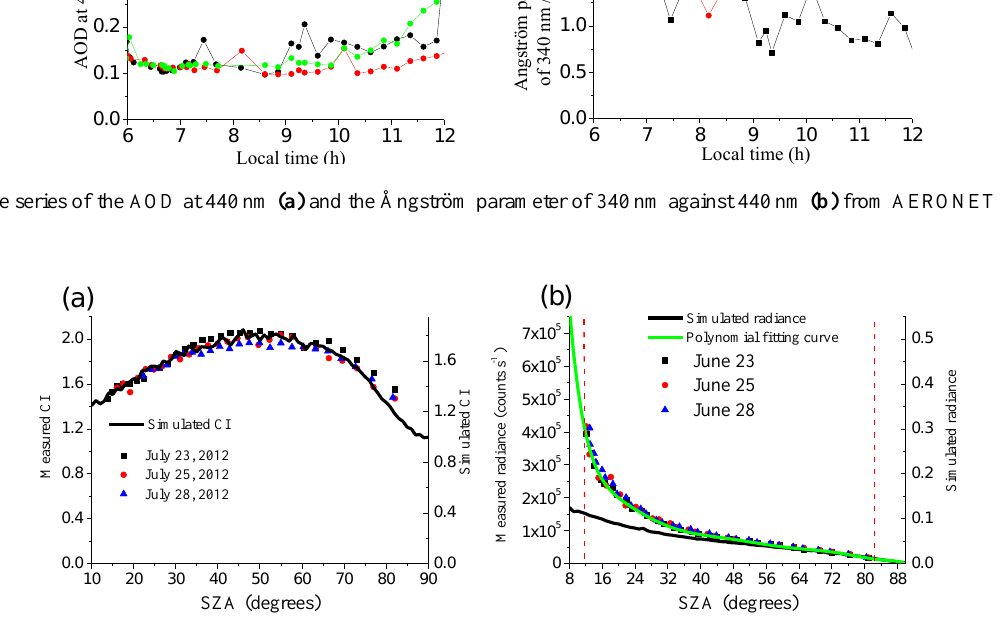
Figure 4. The comparisons of zenith measurements of (a) the CI (340/420nm), and (b) the radiance at 380nm for 3 clear half days with their corresponding values derived from radiative transfer simulations (black lines). In the subfigure (b) the green line indicates the polynomial fit of the measured radiance on the 3 half days; the red dashed lines indicate the SZA of 12 and 82 ◦